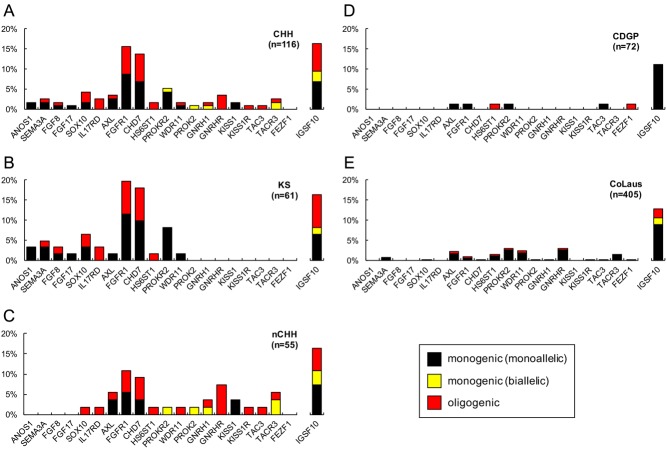
The majority of CHH genes are inherited in a oligogenic fashion in CHH probands, a trend not observed in CDGP probands and CoLaus controls. Histograms showing CHH genes mutational prevalence in (A) CHH, (B) KS, (C) nCHH, (D) CDGP and (E) CoLaus screened individuals. Each bar contains the frequency of each gene inheritance: monoallelic (gray), biallelic (yellow) or oligogenic (red).